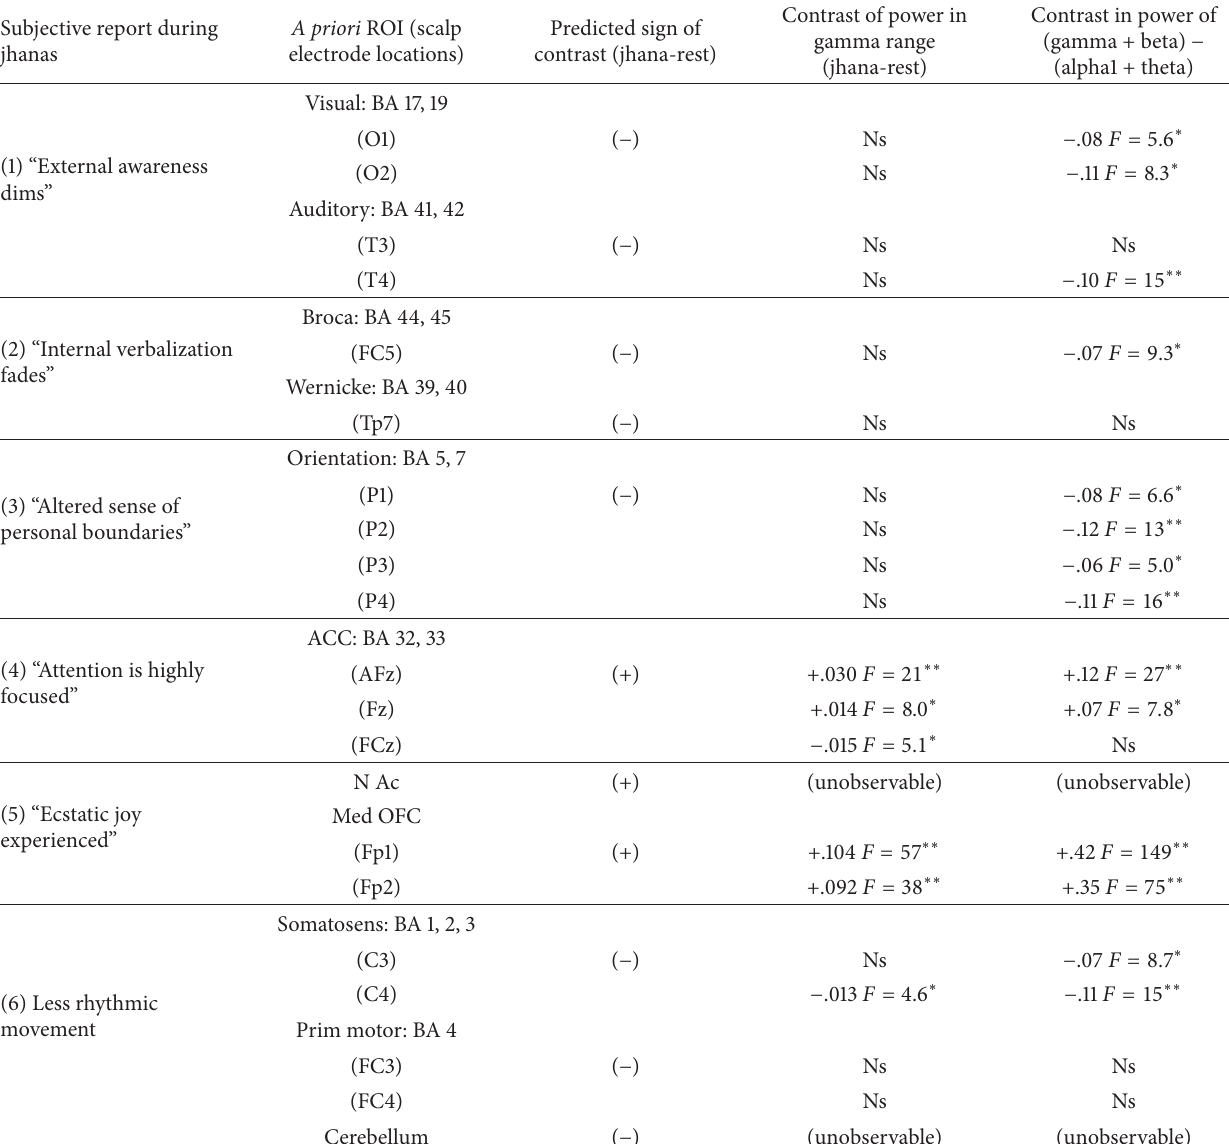
Table 2: Contrasts in the spectral power of the EEG signal in selected bands at a priori defined scalp locations related to 6 hypotheses on jhana activity compared with rest, followed by its 𝐹 -test on the null hypothesis that jhana activity is equal to rest activity. All 𝐹 statistics are with degrees of freedom of (1,502). Contrasts labeled simply “jhana” refer to the pooled activity over all recorded jhanas 2–5. In the last (summary) column, all significant differences are in the direction predicted by the 6